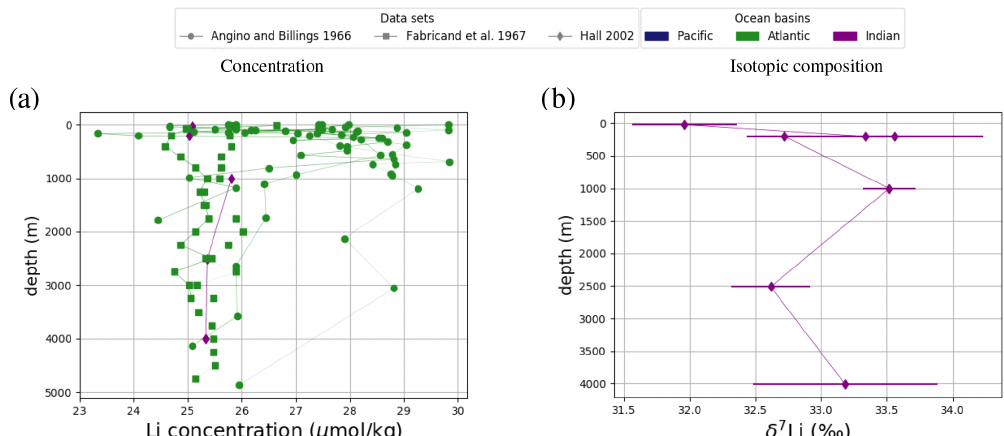
Figure F3. Measured Li ocean profiles. Composites of all available profiles of measured concentrations (a) and isotopic compositions (b) are shown. Data are taken from Angino and Billings (1966), Fabricand et al. (1967), Chan (1987), and Hall (2002). Li concentrations are normalized to a salinity of